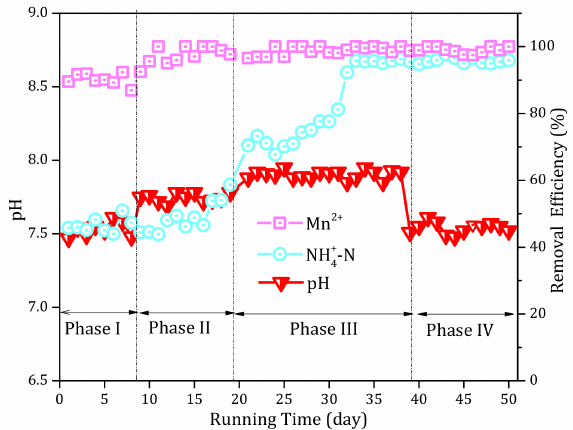
Figure 7. Profiles of the influent pH during the continuous operational period of the pilot filter